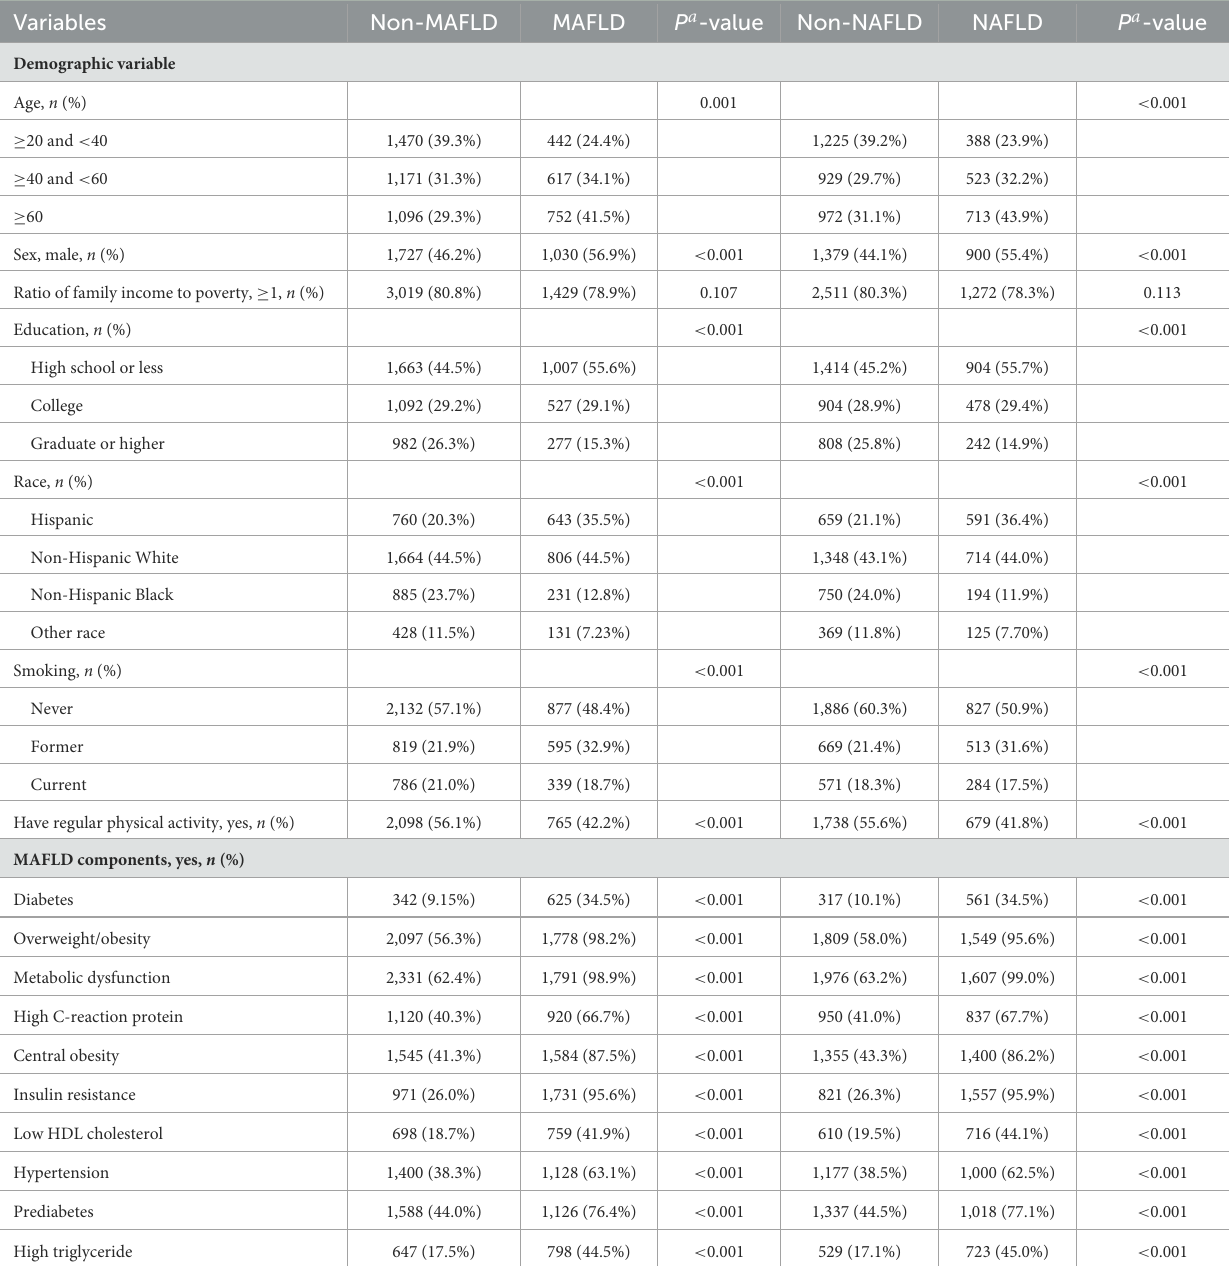
TABLE 1 Demographic characteristics of participants grouped by MAFLD and NAFLD, NHANES 2003–2018 ( N =